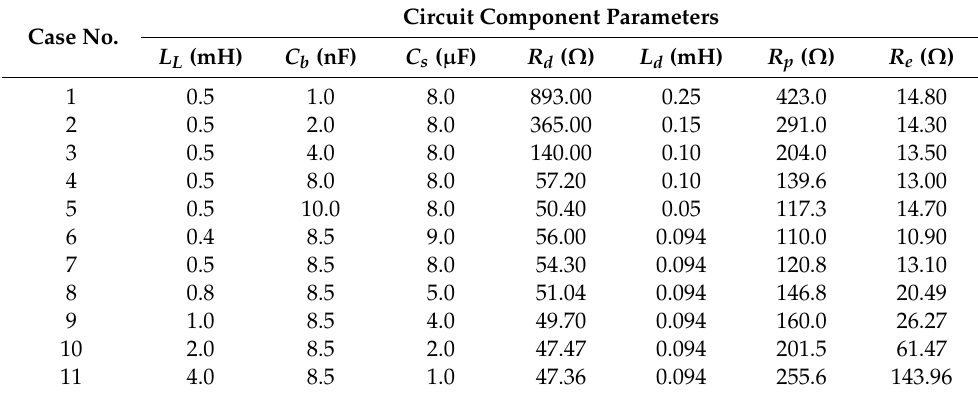
Table 6. Circuit component parameters of the generation circuit used for the validation of the developed model. Case No.